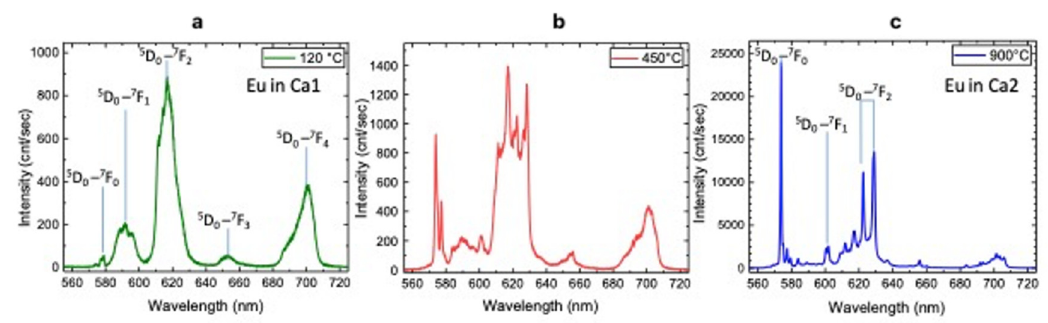
Figure 6. PL spectra of Eu-doped HAp samples after thermal treatments at 120 °C ( a ), 450 °C ( b ) and 900 °C ( c ).